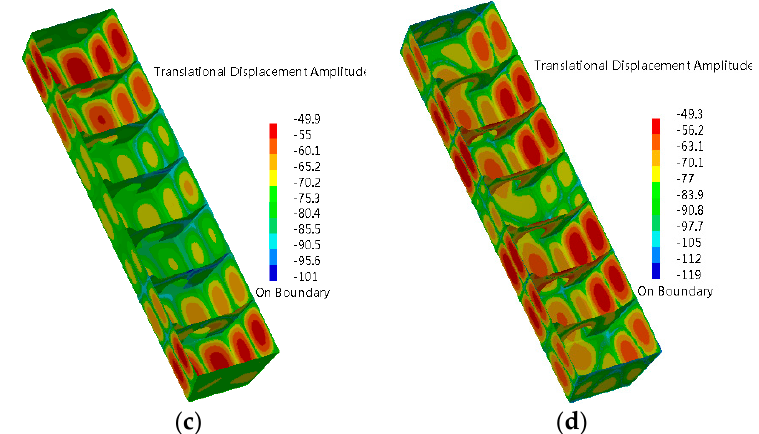
Figure 12. Four of the oil sump’s modal shapes. ( a ) 85 Hz. ( b ) 118 Hz. ( c ) 180 Hz. ( d ) 206 Hz.